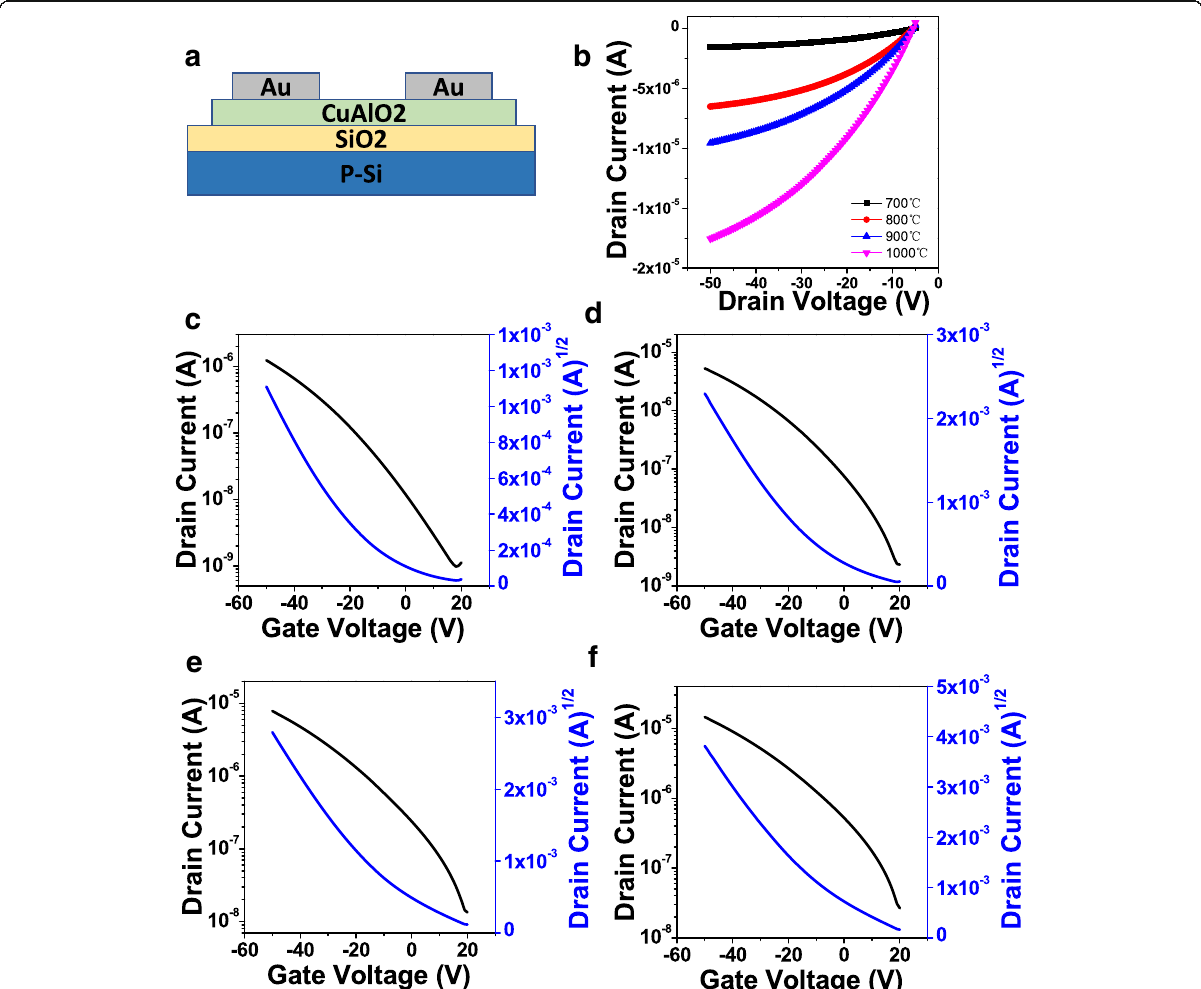
Fig. 5 a Schematic diagram of the CuAlO 2 TFTs. b Summarized output curves. c – f Transfer curves of the CuAlO 2 TFTs annealed at 700 °C, 800 °C, 900 °C, and 1000 °C,